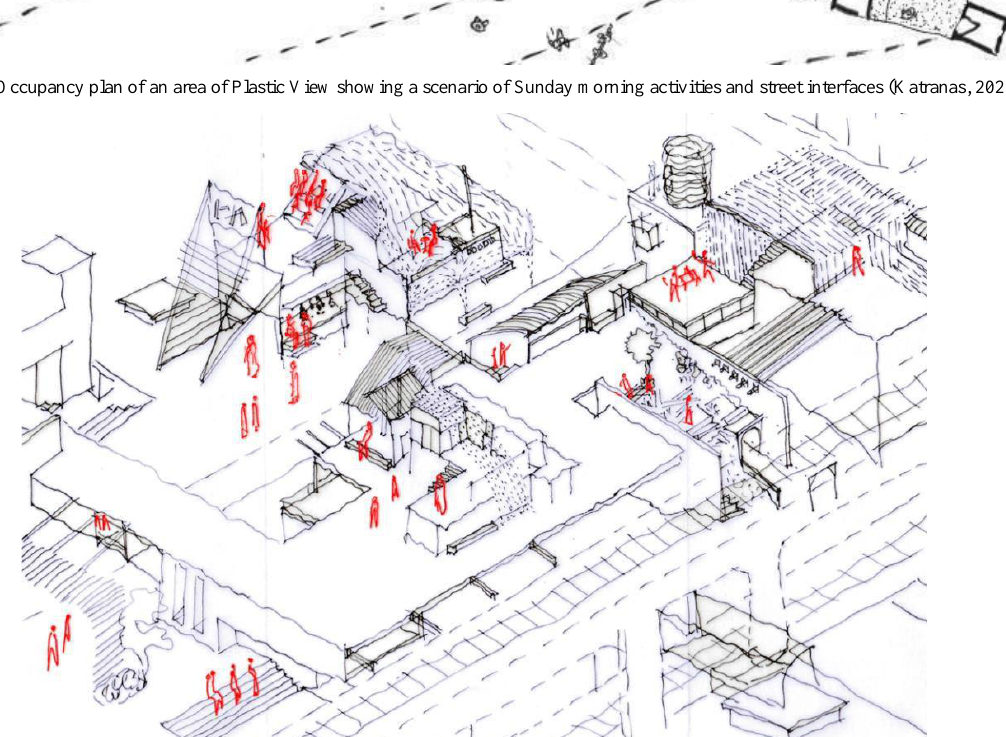
Figure 4. Occupancy plan of an area of Plastic View showing a scenario of Sunday morning activities and street interfaces (Katranas, 2021)